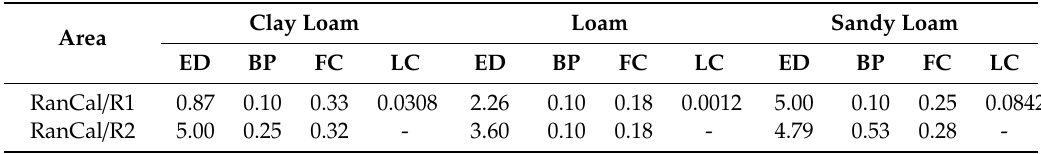
(RanCal). R1 and R2 represent two randomly separated